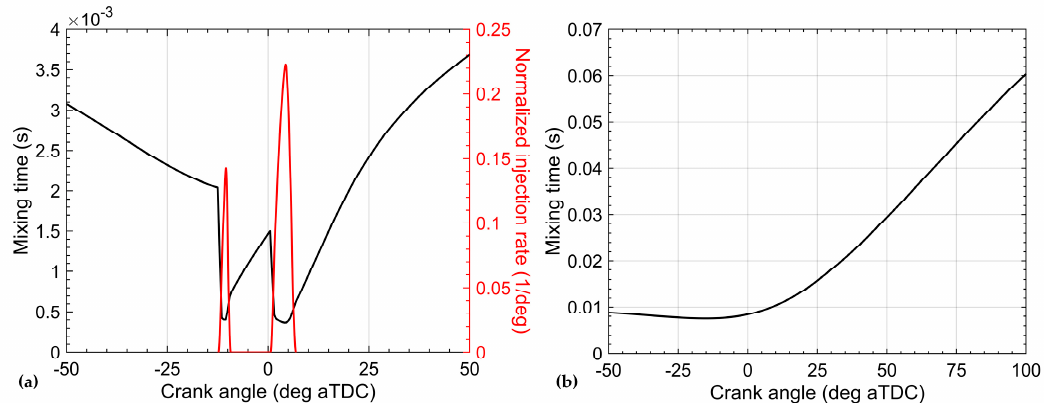
Figure 2. Exemplary mixing time histories computed using turbulence models for ( a ) Diesel engine conditions [47] and ( b ) gasoline engine conditions [49].